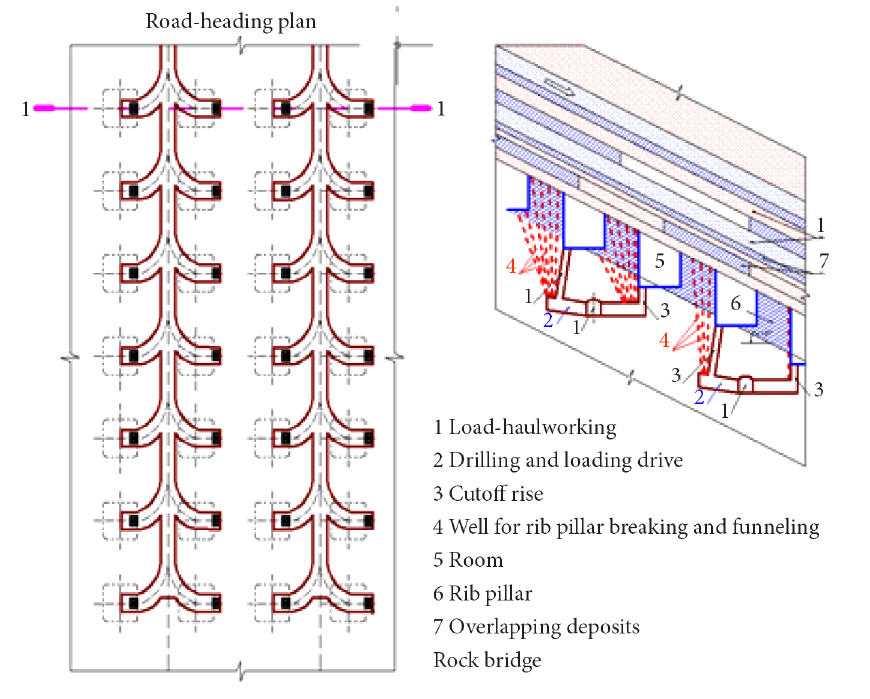
Figure 1. The proposed design of the drawing of caved ore from the rib pillar at the stope sill in the rock mass of inclined overlapping deposits